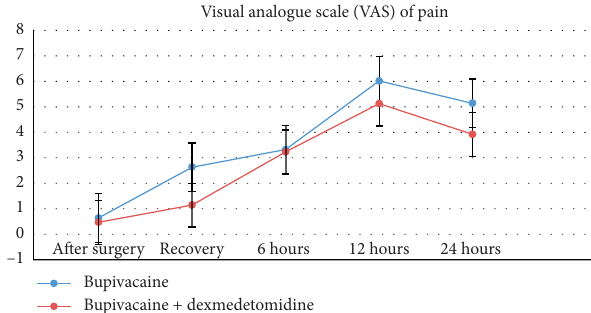
Figure 4: Comparison of visual analog scale (VAS) of pain in patients’ groups within 24 hours after surgery. Te VAS score in all hours of study in the intervention group was lesser than the control group and it was signifcant P � 0.001.